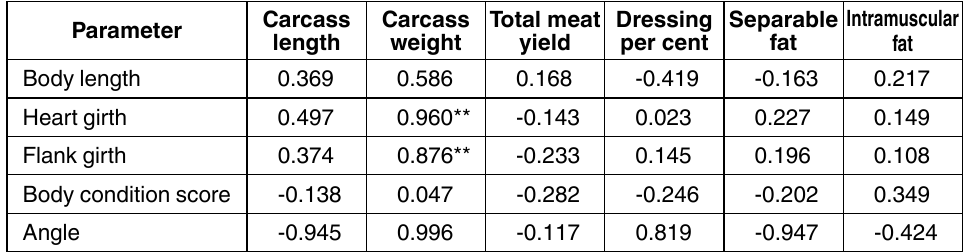
table 3. Coefficients of correlation between different live animal and carcass parameters of pigs from weight group III